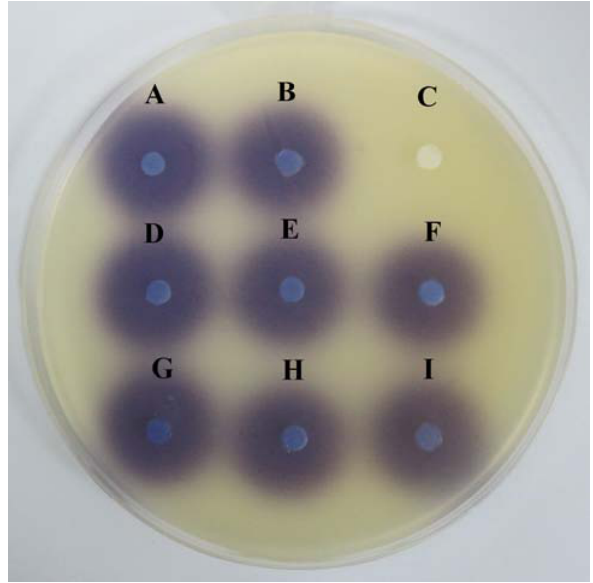
Figure 4. Caffeine did not degrade C6-HSL. Disc ( A ) C6-HSL treated with ultrapure water (negative control); ( B ) C6- HSL treated with 20% DMSO (negative control); ( C ) PBS; ( D ) C6-HSL treated with 0.1 mg/mL caffeine; ( E ) C6-HSL treated with 0.2 mg/mL caffeine; ( F ) C6-HSL treated with 0.3 mg/mL caffeine; ( G ) C6-HSL treated with 0.1 mg/mL (+)-catechin; ( H ) C6-HSL treated with 0.2 mg/mL (+)-catechin; ( I )